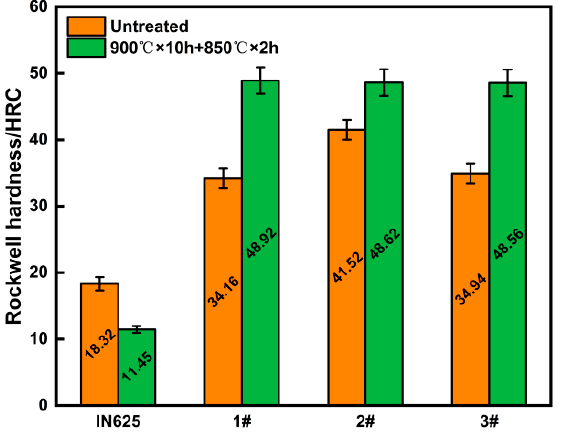
Figure 6. Hardness of four kinds coatings before and after heat